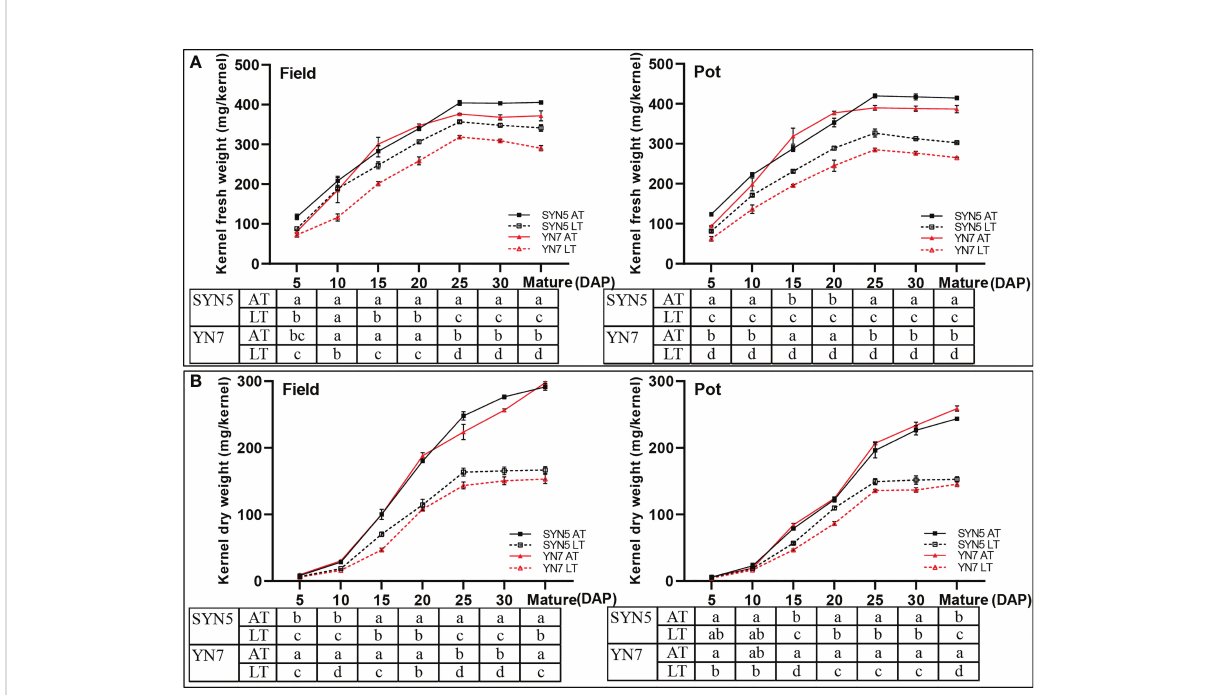
FIGURE 2 Effect of post-silking LT on the kernel fresh and dry weights of waxy maize during grain fi lling stage. (A) , kernel fresh weight; (B) , kernel dry weight. Error bars denote standard errors from three replicates, and different letters at the same sampling date indicate signi fi cant difference at P <